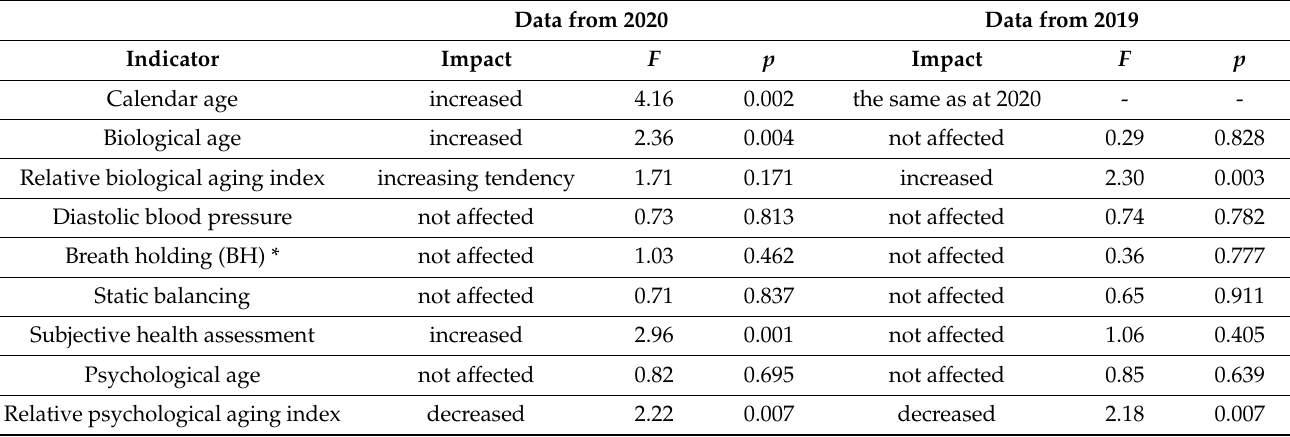
Table 4. Influence of biopsychological age indicators on the occurrence of COVID-19 in men of the working group.